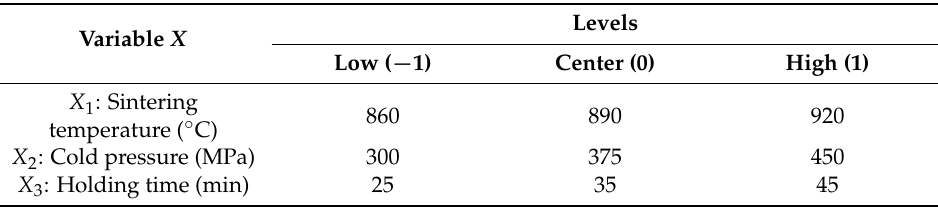
Table 2. The actual value and coding of the